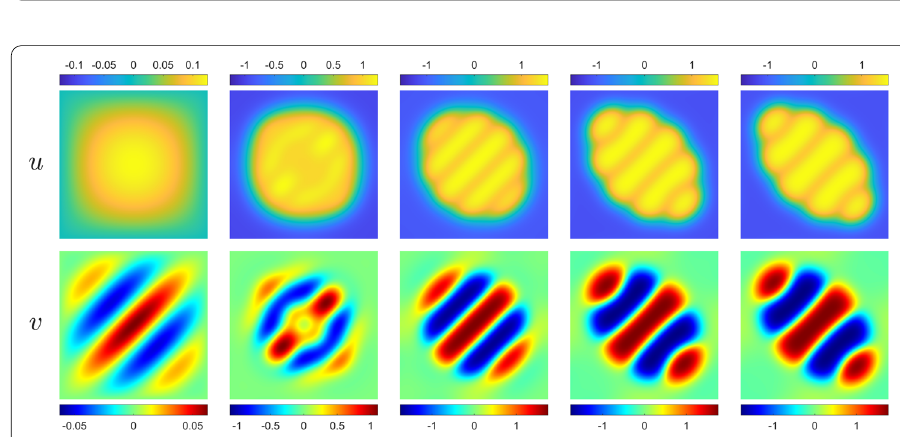
Figure 3 The evolution of the phase transition u and v with initial data (4.2). From left to right: t = 0,0.2,0.3,0.8,50. The parameters are ε u = 0.05, ε v = 0.05, M u = 1, M v = 0.05, α = 0.01, β = –0.9, σ = 100, S = 10, T = 50, δ t =